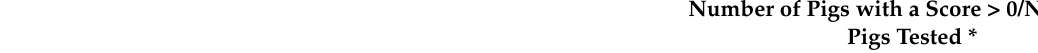
Table 4. Results of the histopathological analysis of the different studied lymphoid tissues from vaccinated and control pigs after PCV2